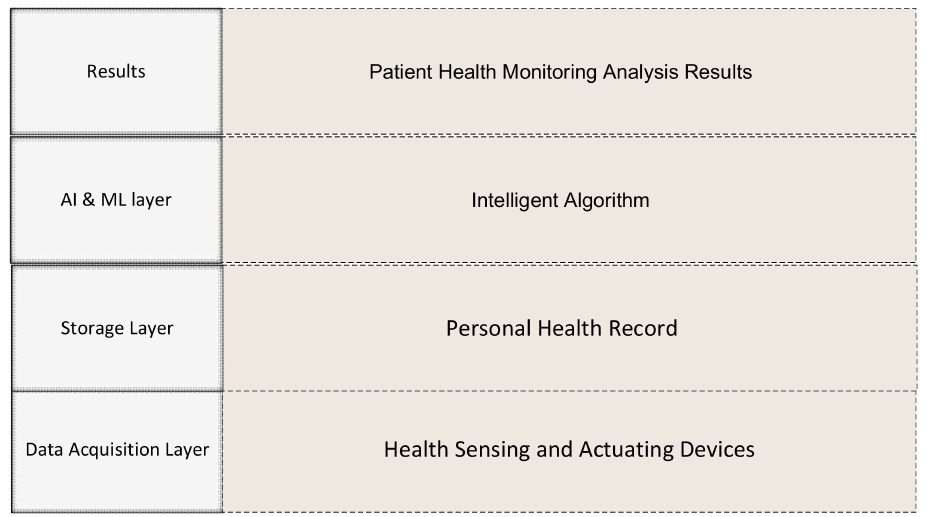
Figure 4. The perspective architecture of intelligent and secured